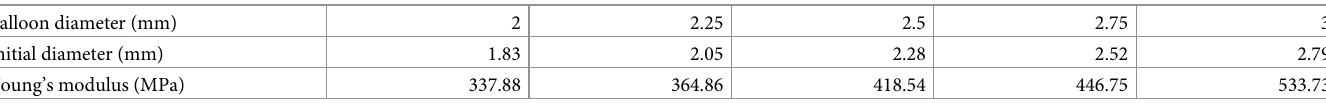
where I and I are the first and second invariants of the Cauchy–Green tensor and a 1 2 are the hyperelastic constants of 18.90 kPa and 2.75 kPa referenced from the experimental data of human femoral artery [22]. A nanoindentation study showed that the elastic modulus of human calcified plaques collected from the superficial femoral artery wall was 20.1 GPa [23]. Another nanoindentation study of human carotid bifurcation plaque specimens showed that the majority of the modulus were in the range of 100 MPa to 10 GPa, with some as high as 21 GPa [24]. They reported that variations in tissue composition, incomplete mineralization, and sample preparation might be the source of the variations. Their follow-up study with reducing the cause of these potential errors showed that the modulus of calcification ranged from 15 to 25 GPa [25]. In this study, the material property of the calcification model was defined as an isotropic elastic material model with Young’s modulus of 20.1 GPa, and Poisson ratio was assumed to be 0.3. Mesh sensitivity tests were conducted to ensure the mesh convergence for each model. Mesh densities for the cutting balloon models and calcified artery model showed negligible divergence (i.e., accepting difference of less than 1% in maximum radial displace- ment) in comparison with finer meshes. Table 1. Initial diameters and Young’s moduli of the balloons, obtained using finite element analysis. Balloon diameter